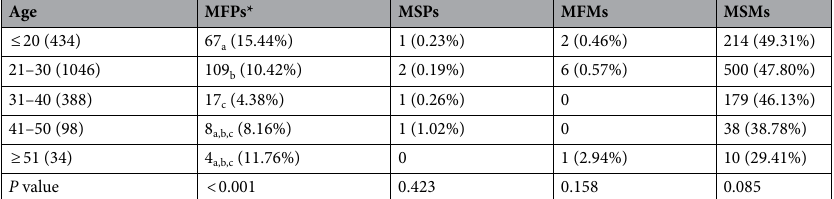
Table 6. Prevalence of CSRCs in different tooth positions among different age groups. CSRCs: C-shaped root canals, MFPs: mandibular first premolars, MSPs: mandibular second premolars, MFMs: mandibular first molars, MSMs: mandibular second molars. *The Z-test revealed there was a significant difference in the prevalence of CSRCs in MFPs among age groups (each subscript letter denotes a subset of age categories whose column proportions do not differ significantly from each other at the 0.05